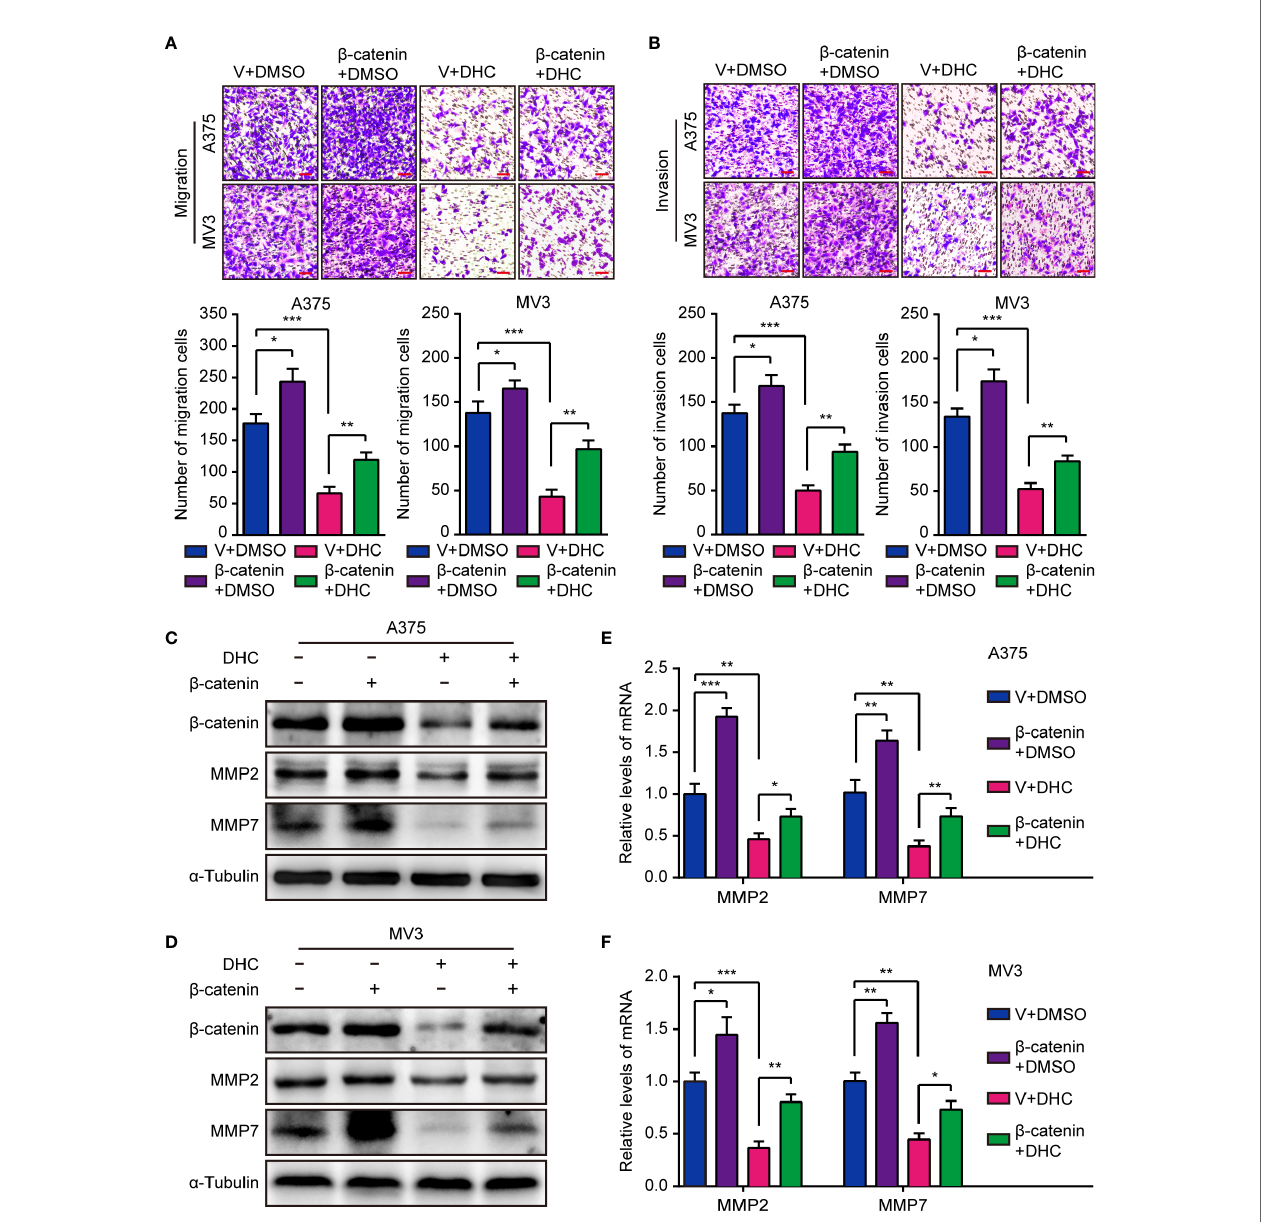
FIGURE 5 | Overexpression of b -catenin retrieves DHC-induced cell migration and invasion inhibition. (A, B) Migration and invasion transwell assays were performed in b -catenin/vector overexpressed A375 and MV3 cells treated with 100 m M DHC. Scale bar, 100 m m. (C, D) The protein expression of b -catenin, MMP2, and MMP7 in b -catenin/vector overexpressed A375 and MV3 cells treated with 100 m M DHC for 48 h. (E, F) The mRNA expression of MMP2 and MMP7 in b -catenin/ vector overexpressed A375 and MV3 cells treated with 100 m M DHC for 48 h. * P <0.05; ** P <0.01; *** P <